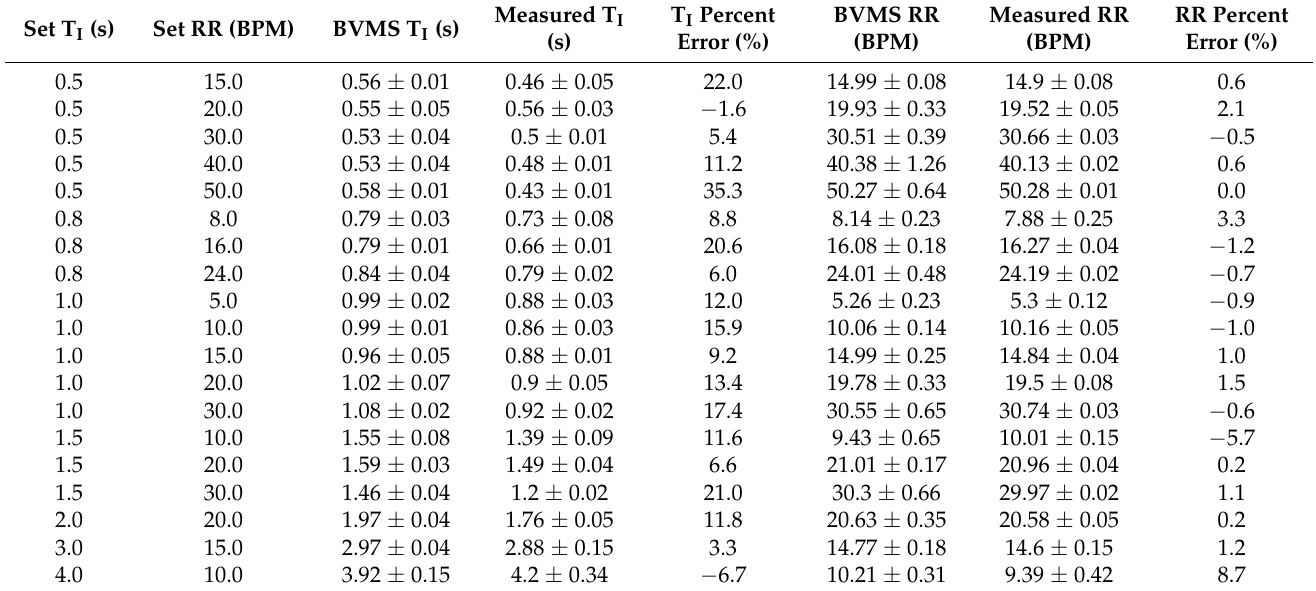
Table 3. Outcomes of Part 2 of Test 1. Measured T I and RR of the patient at different settings of T I and RR. T I and RR were set using the BubbleVent monitoring system (BVMS) and measured using the ASL 5000.